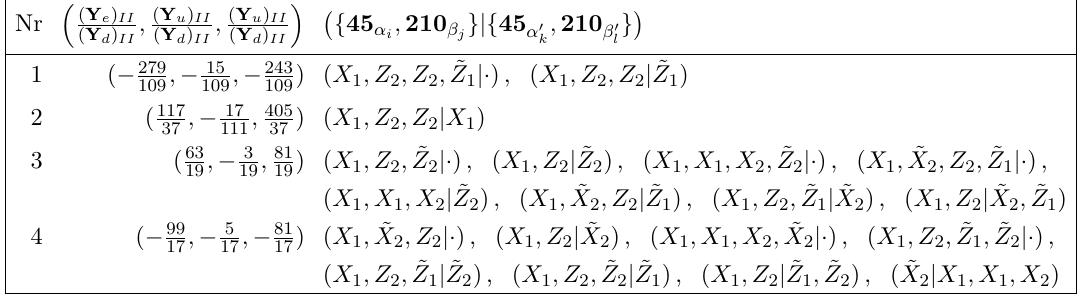
Table 8 . Operators with up to 4 GUT-scale VEVs in discrete directions, which can be used for the O 22 operator to provide a good (cid:12)t (cid:31) 2 < 1 in (cid:12)gure 2. The ratios were computed from eq. (2.18)